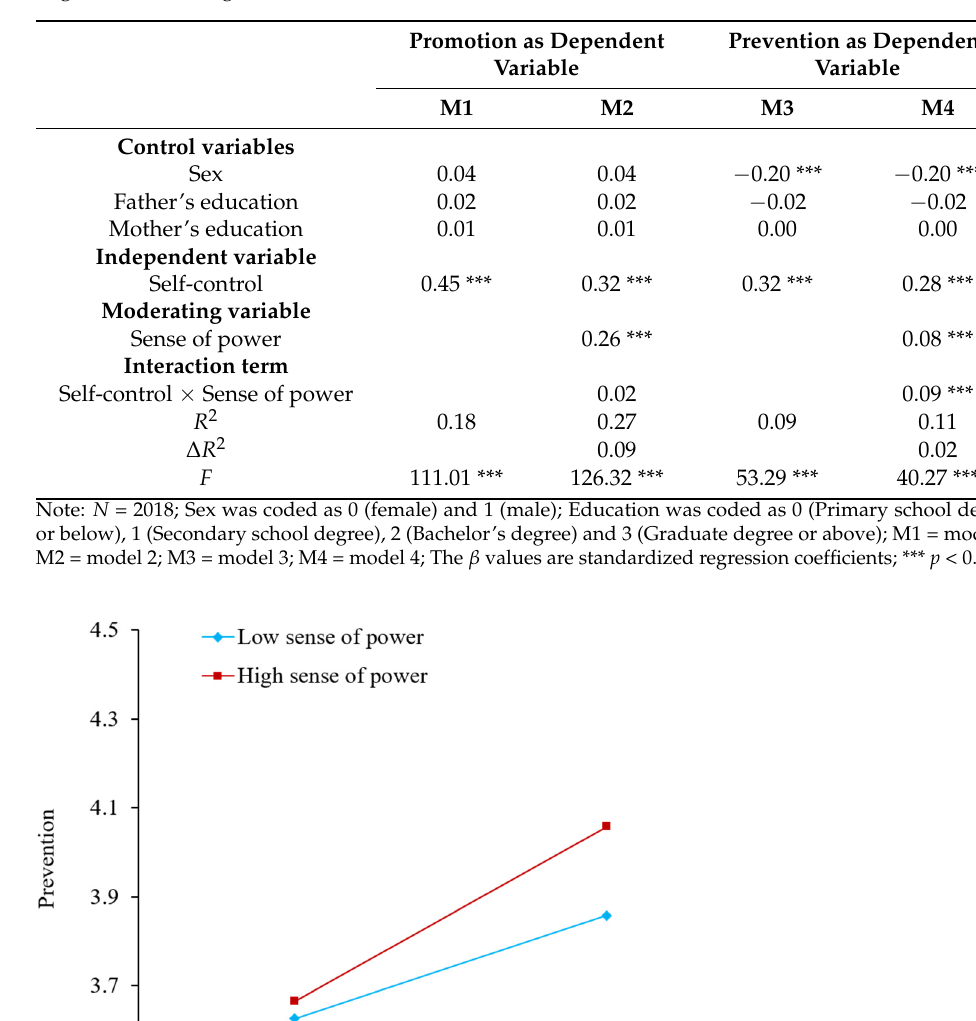
Table 3. Regression results for the analysis of the moderated mediation effect of self-control on negative risk-taking behaviors.